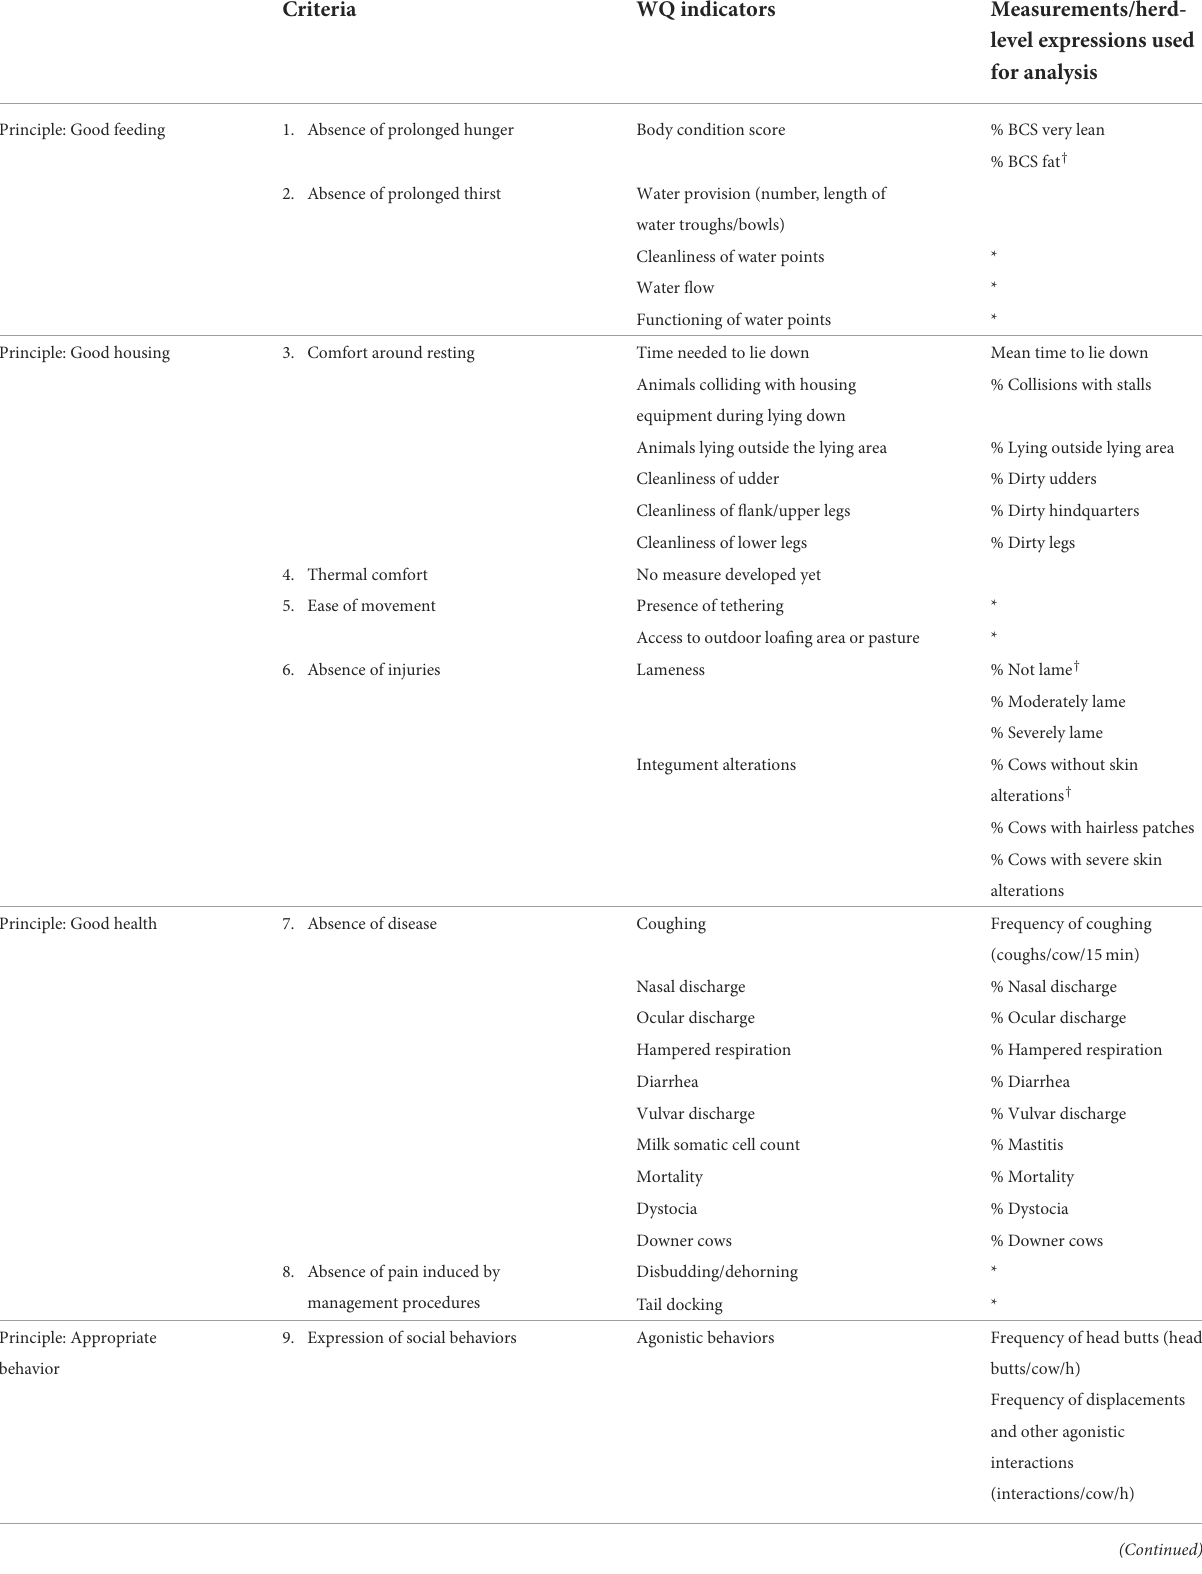
TABLE 1 Overview of WelfareQuality ® principles, criteria, and measurements as well as the expressions at herd level used for the analysis [Table modified from (12)]. Criteria WQ indicators Measurements/herd-